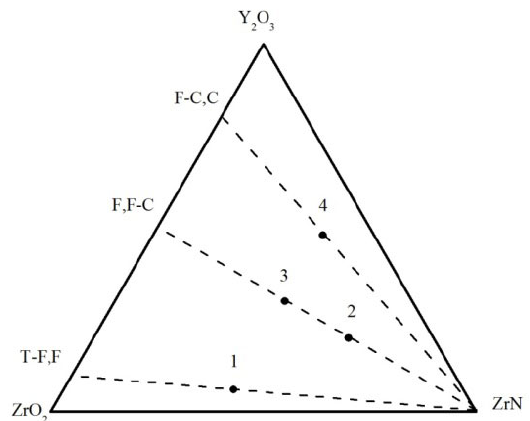
Fig. 3 Phase diagram of ZrN–ZrO 2 –Y 2 O 3 ternary system.